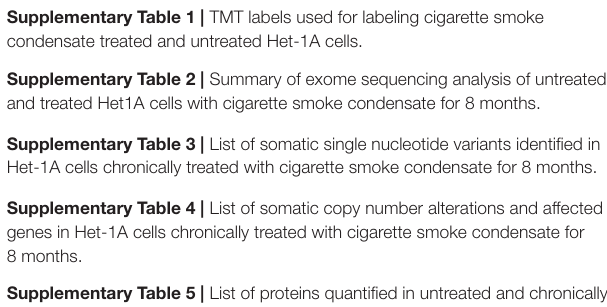
Supplementary Figure 1 | Whole exome sequence analysis of Het-1A-8M. (A) Summary of transitions and transversions identified in cigarette smoke condensate treated cells. (B) Summary of somatic variants identified in response to cigarette smoke condensate treatment. Supplementary Figure 2 | Chronic treatment with cigarette smoke condensate alters cellular proteome of esophageal cells. (A) Expression profile of proteins that showed downregulation in cigarette smoke condensate treated cells as a function of duration of exposure. (B) Expression profile of proteins that showed hyperphosphorylation in cigarette smoke condensate treated cells, as a function of duration of treatment. Supplementary Figure 3 | Gene ontology-based annotation of differentially phosphorylated proteins identified in Het-1A-Smoke-8M cells. Classification of proteins based on (A) subcellular localization. (B) Molecular function. Supplementary Figure 4 | Genes affected by copy number loss in cells chronically treated with cigarette smoke condensate (Het1A-Smoke-8M). DNAJC8 , ARID1A, GPN2, MAP3K6, WASF2, RPS6KA1 . Supplementary Figure 5 | Representative IGV snapshot of SNV bearing genes. WWOX (exon5:c.A425T:p.K142M), BIRC6 (exon73:c.A14270G:p.K4757R), NSD1 (exon5:c.C1688G:p.T563S and exon6:c.C881G:p.T294S), GAS2 (exon6:c.C548A:p.S183Y), ALDH1L1 (exon2:c.A74G:p.E25G), and EGFR